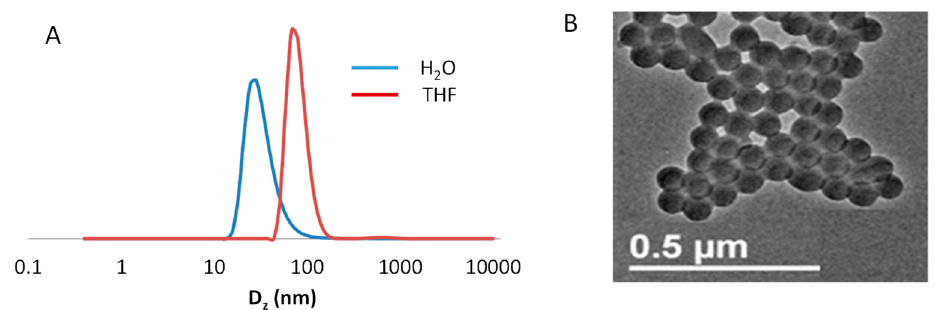
Figure 3. Characterization of the nixantphos@CCM particle size and morphology: DLS of dispersions in water and THF ( A ) and TEM image ( B ).